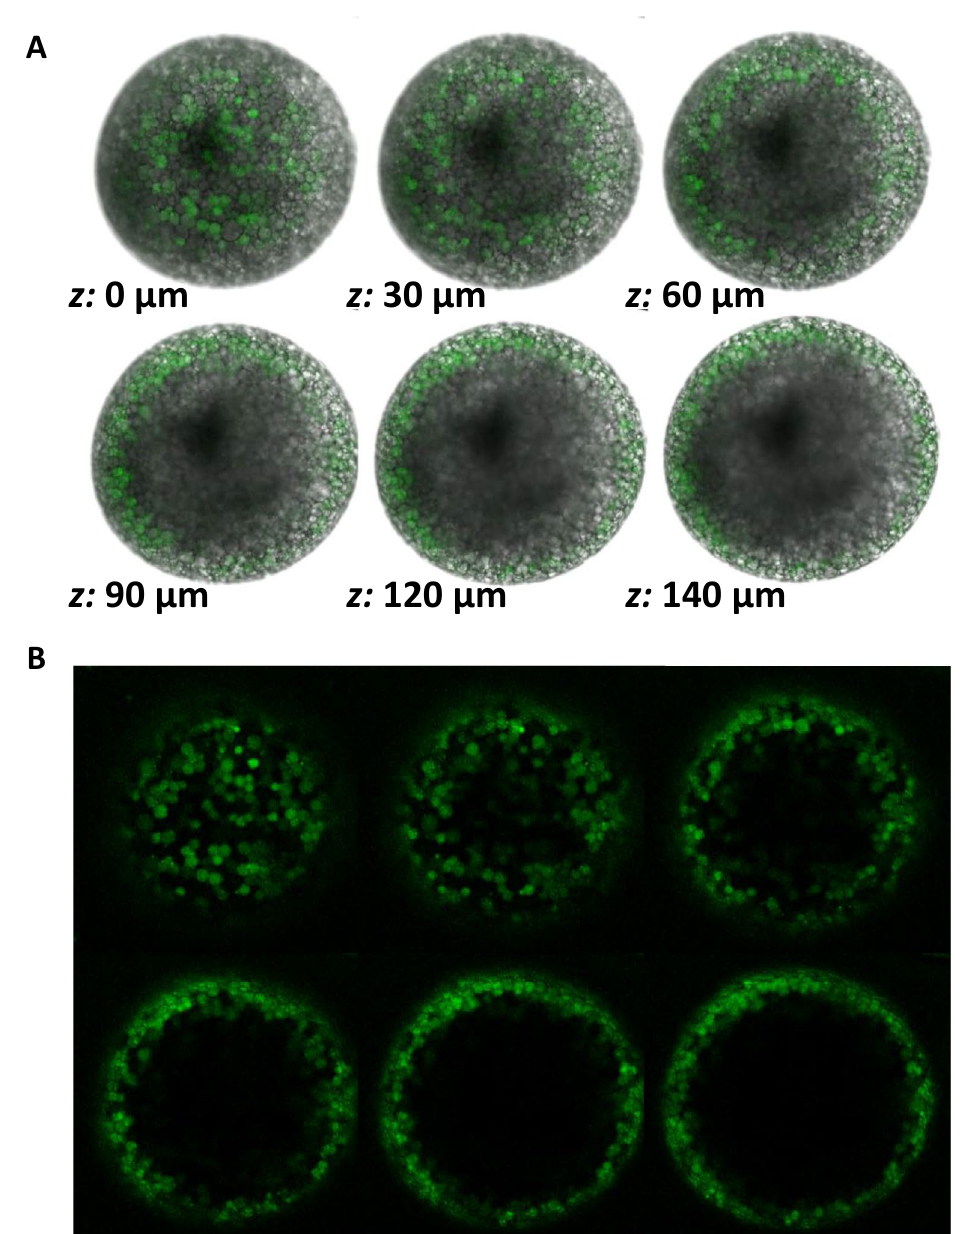
Figure 4. Meiosis II-arrested wildtype zebrafish eggs have cortically-localized, zinc-containing vesicles. (A, B) colocalization (A) of FluoZin-3-AM signal (green fluorescence) and cortically-located vesicles by brightfield and fluorescent microscopy. Images represent optical slices, with relative location to bottom ( z : 0) of egg